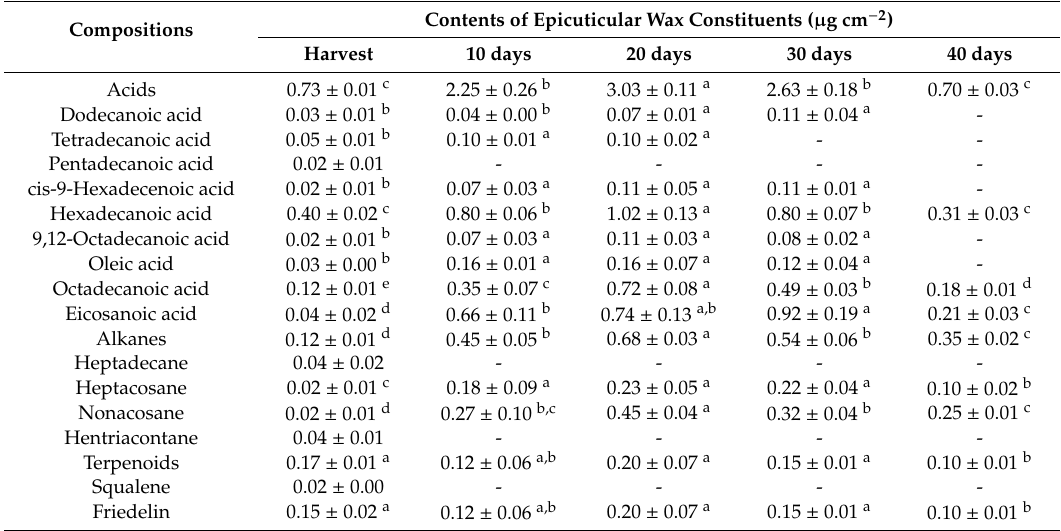
Table 2. Epicuticular wax constituents of ‘Satsuma’ mandarin fruits during storage.